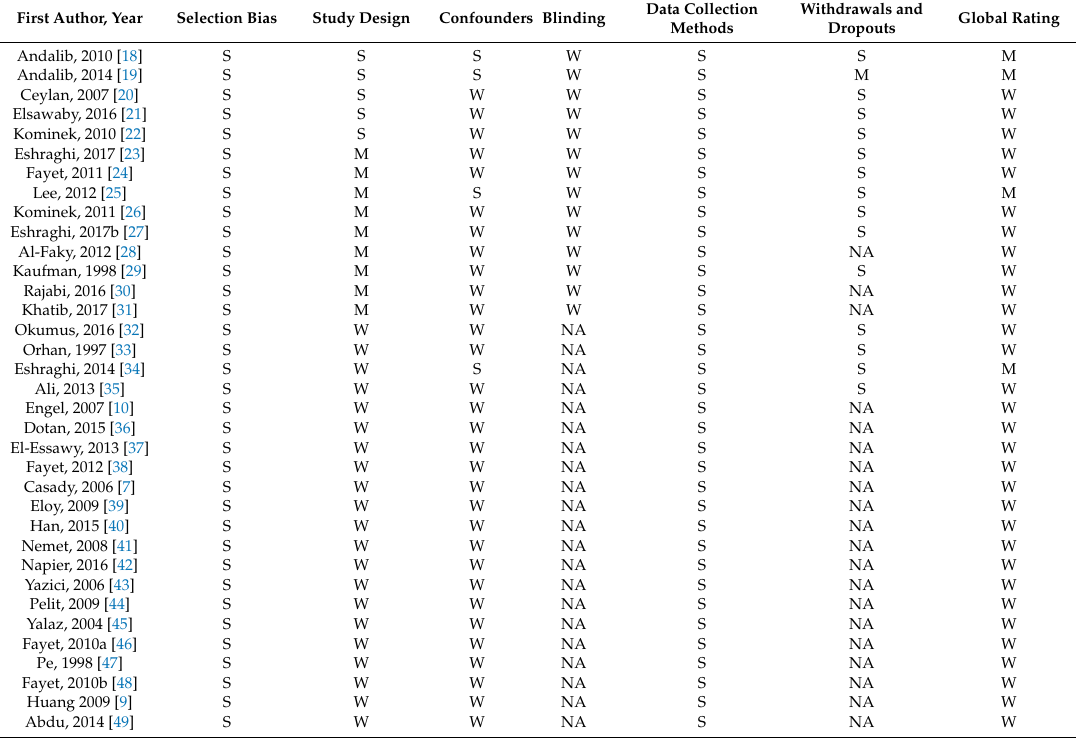
Table 3. EPHPP quality assessment tool rating for individual